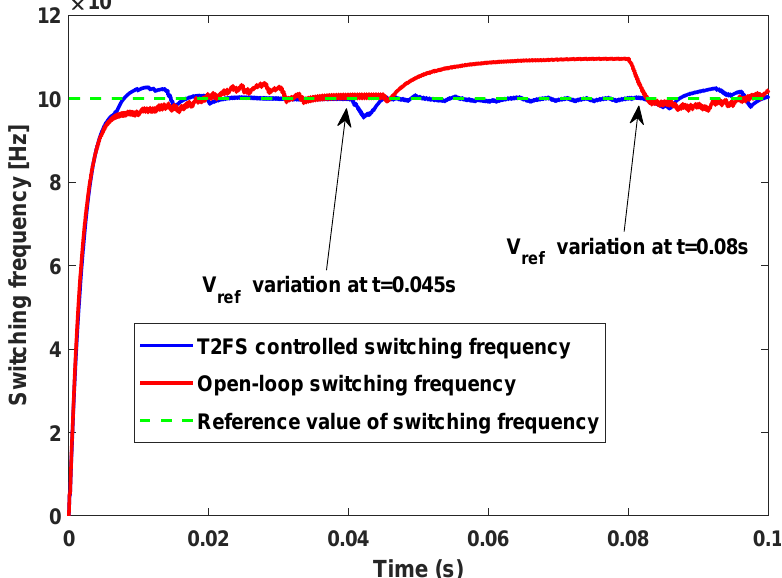
Figure 15. Dynamic response of switching frequency under reference voltage